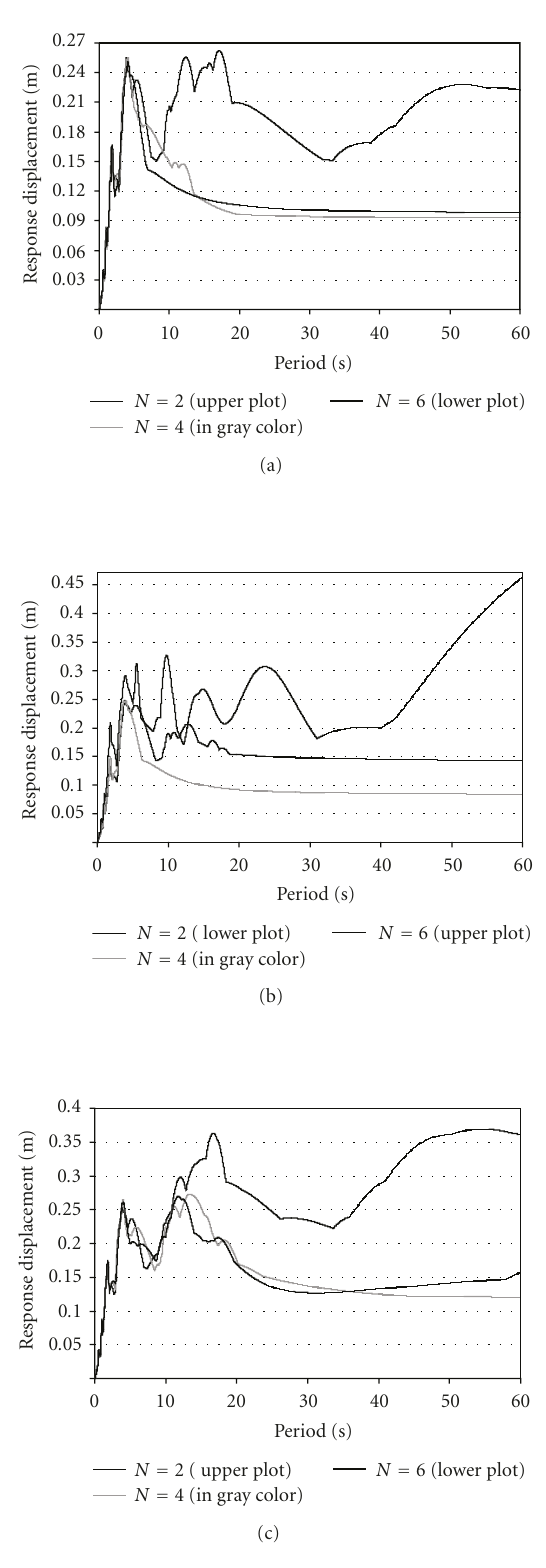
Figure 5: Displacement response spectra for bandpass filtered Izmit record, NS component, using (a) Butterworth, (b) Chebyshev (3dB), (c) Bessel